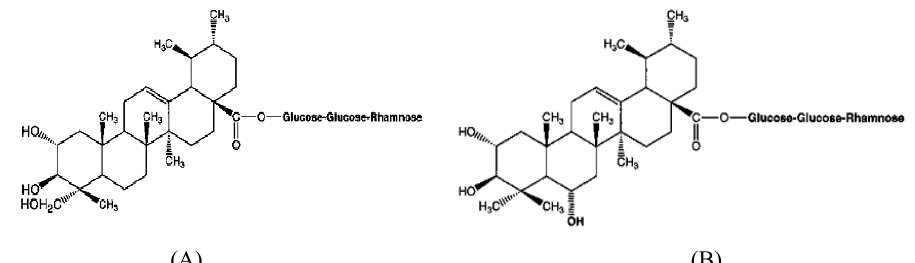
Figure 1. Triterpenes of Centella.